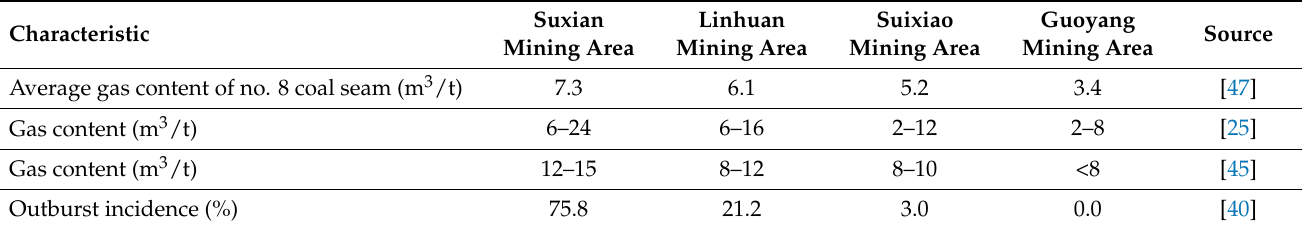
Table 1. The gas characteristics of the Huaibei coalfield.